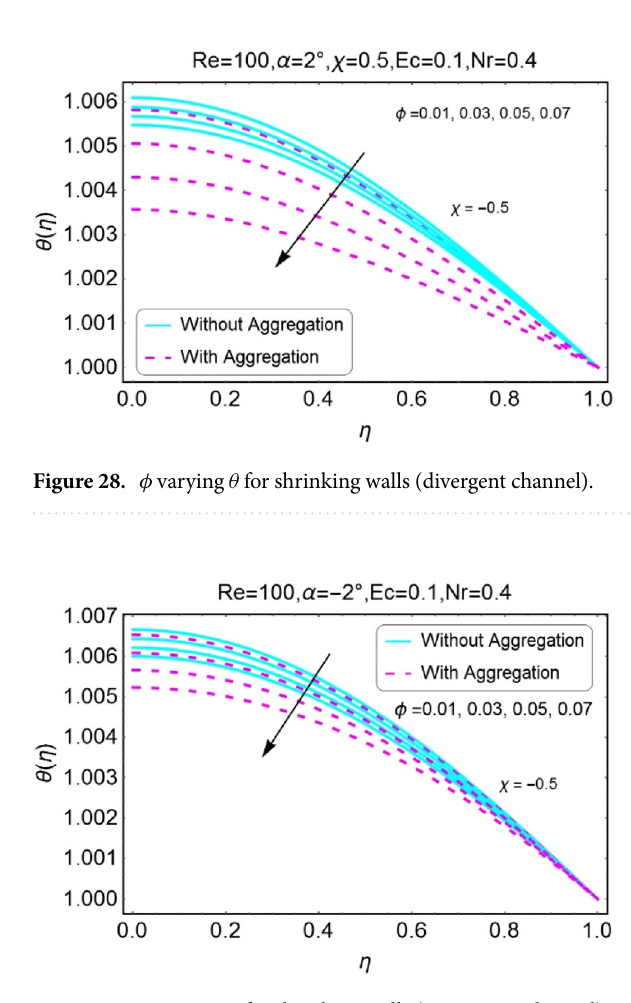
Figure 29. φ varying θ for shrinking walls (convergent channel).